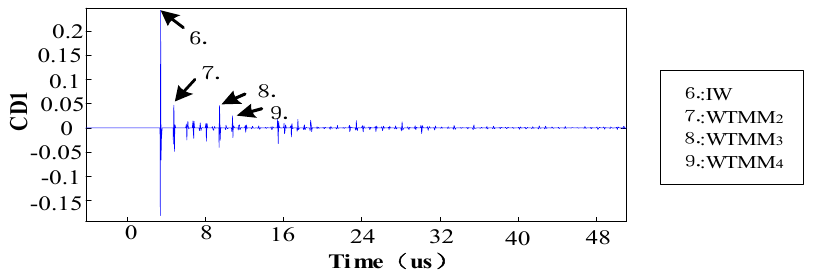
Figure 5. Wavelet-transform modulus-extremum (WTME) of the aerial-mode TW.